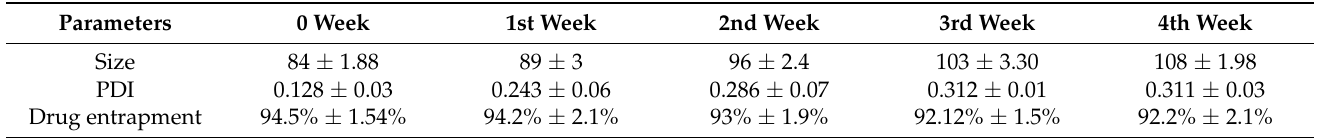
Table 7. Stability